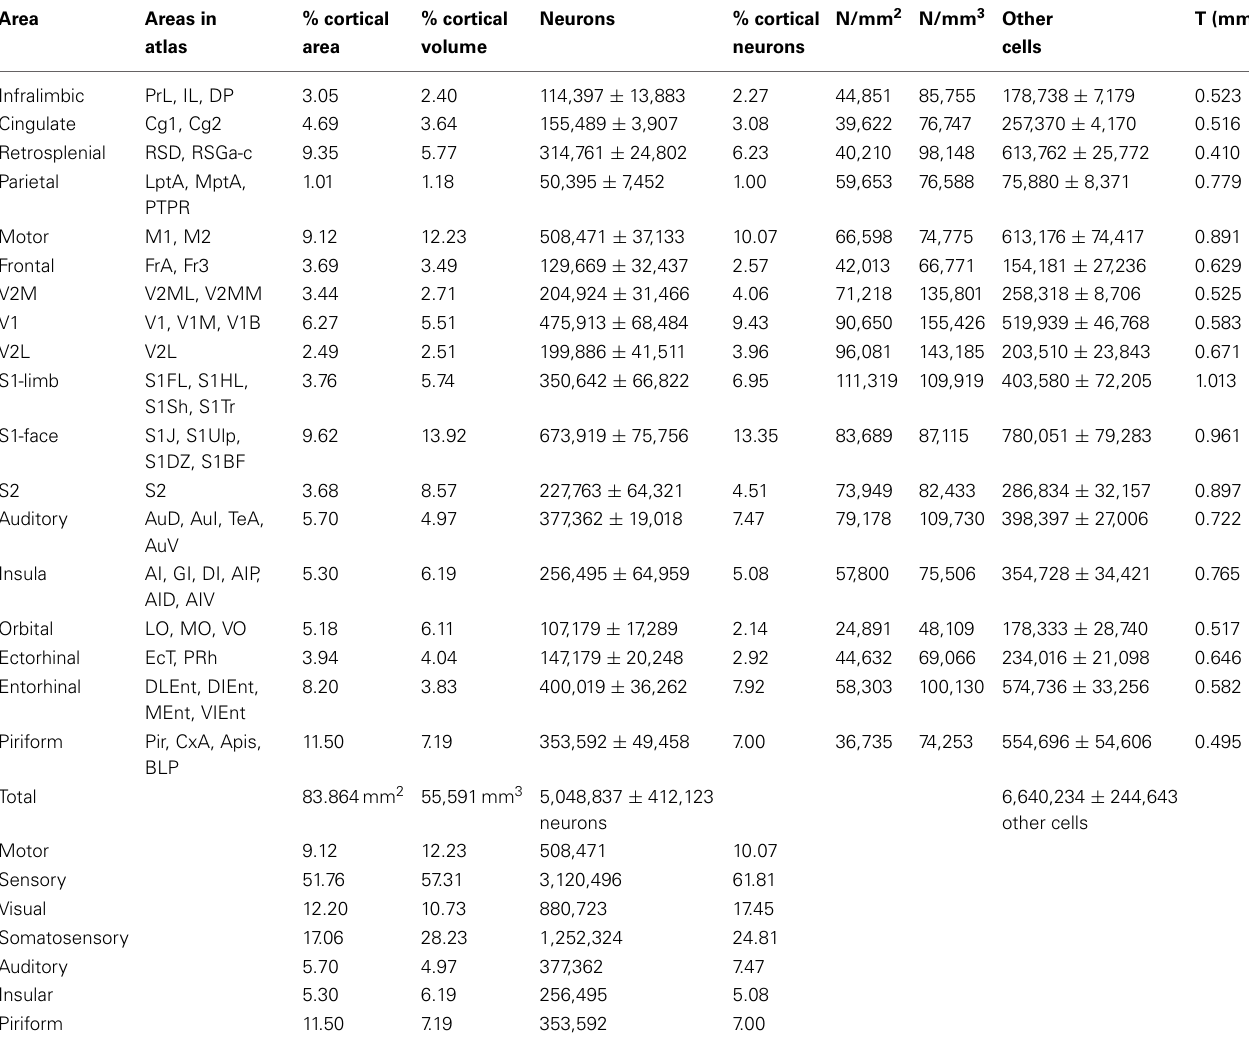
Table 1 | Distribution of neurons across cortical areas in the mouse